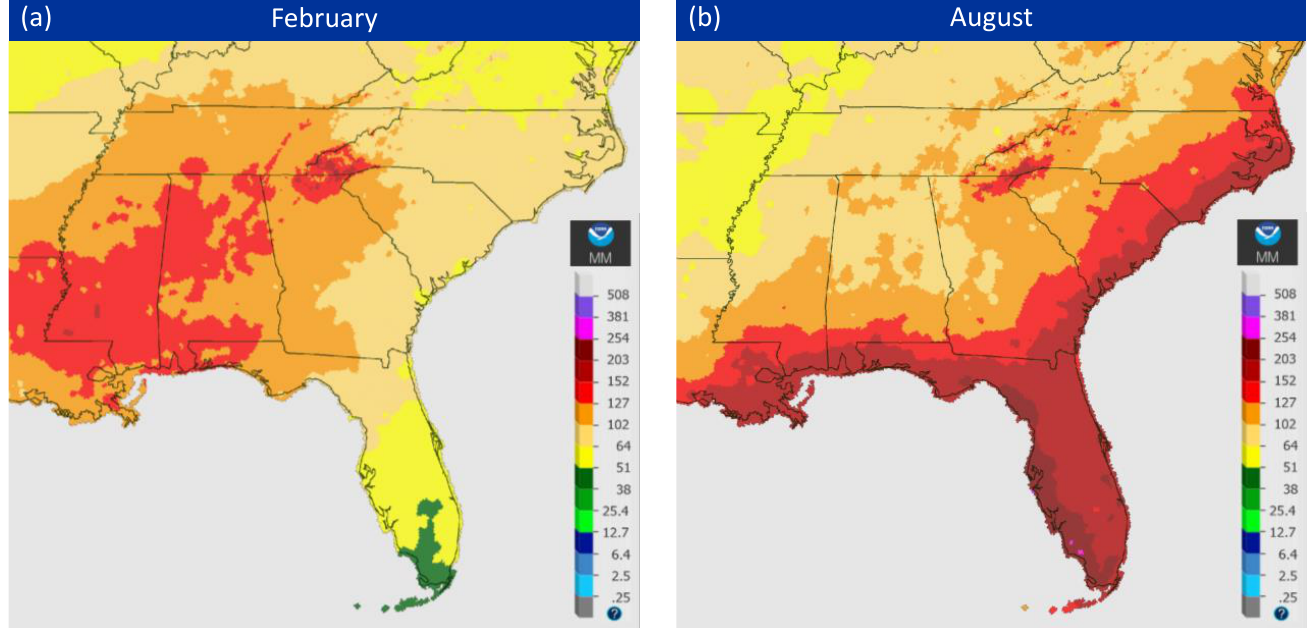
Figure 7. Monthly average precipitation (mm) for ( a ) February and ( b ) August based on the 30-year (1981–2010) Parameter-elevation Regressions on Independent Slopes Model (PRISM) dataset. Images obtained from [33].